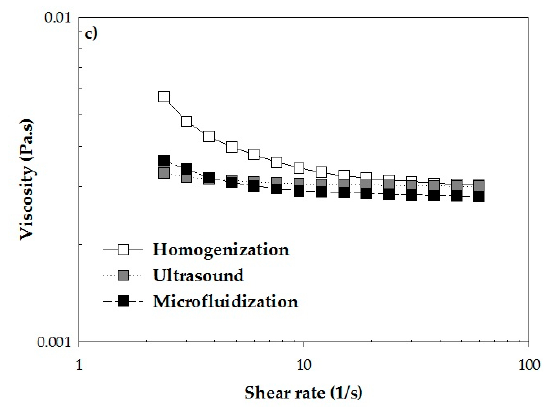
Figure 6. Effect of emulsifier type: ( a ) SA: Stearic acid; ( b ) T80: Tween 80; and ( c ) T80/S60: Tween 80/Span 60, and shear process: homogenization, ultrasound and microfluidization, on rheological behavior of beeswax–starch nanoemulsions.